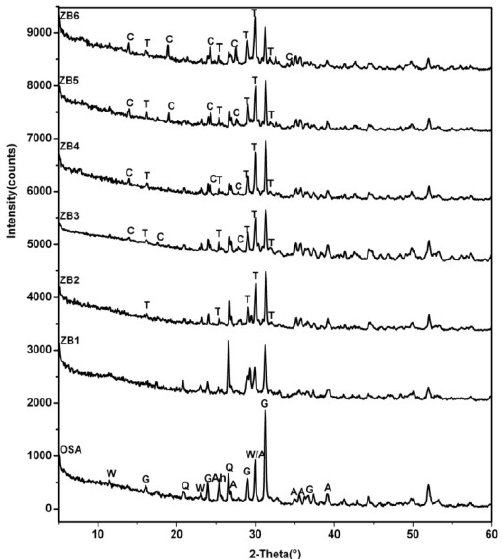
Figure 2. XRD patterns of alkali activated